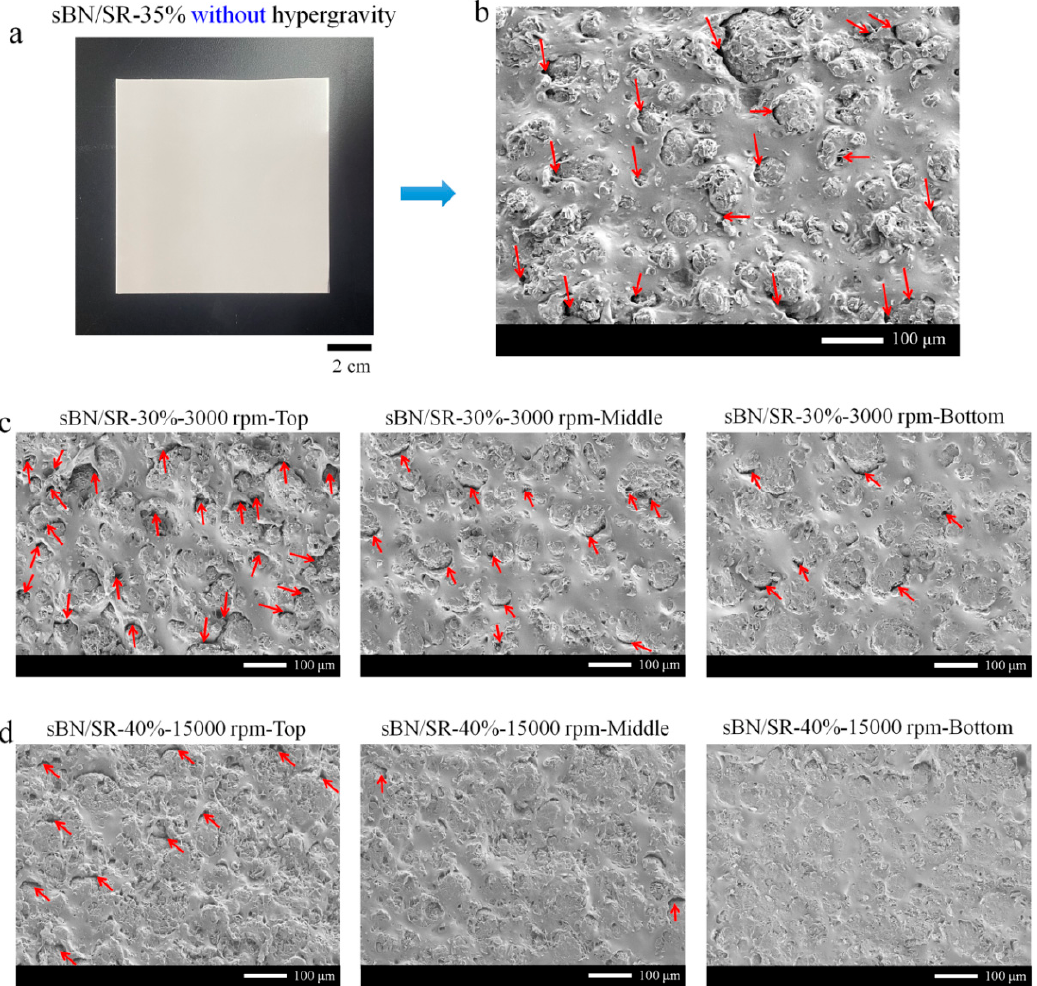
Figure 4. The microstructures of sBN/SR composites. ( a ) Photograph of sBN/SR composite prepared by mechanical mixing and molding (without hypergravity treatments). ( b ) SEM images of the cross-section of sBN/SR composites shown in ( a ). ( c , d ) SEM images of the cross-sections of sBN/SR composites prepared with hypergravity treatments. The red arrows refer to micro-cracks. It is clear that hypergravity treatments can remove micro-cracks and bring more compacted microstructures to the composites. Scale bars in SEM images: 100 μ m.